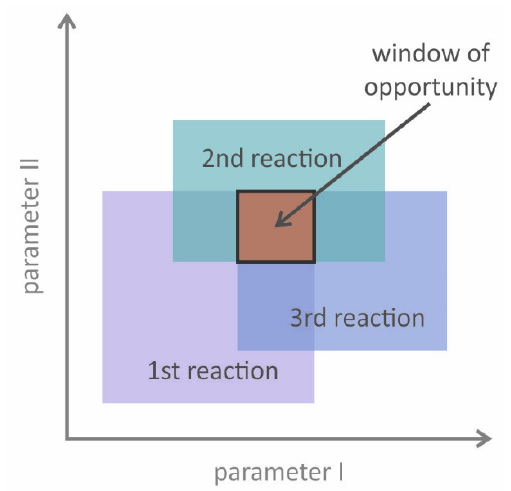
Figure 5. Each reaction of an enzymatic cascade is optimally catalyzed under certain conditions and the overlapping ranges define the window of opportunity of the whole system. This window of opportunity predefines the parameter ranges of the cascade and it can become narrower with more reactions and parameters to be changed. In this figure, only two parameter dimensions are displayed, although many more can define the tolerated window.